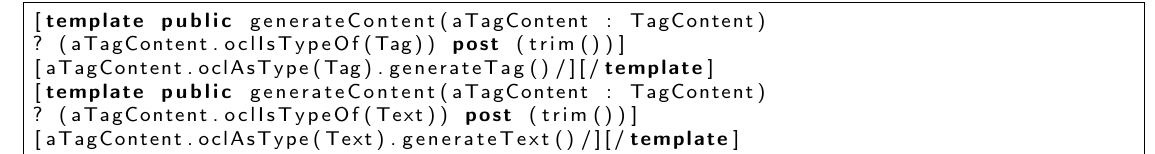
Figure 10. Plain text generation template in ACCELEO.